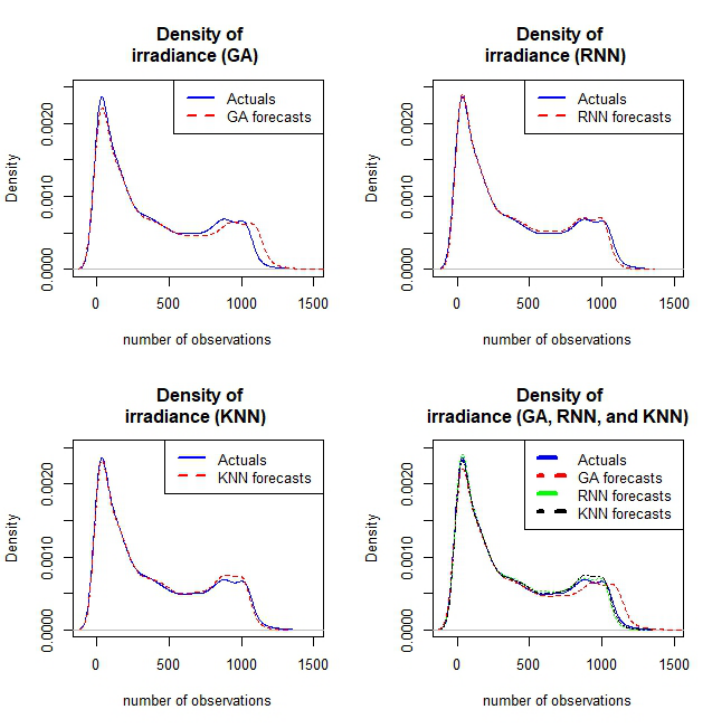
Figure 5. Density plots of the actual GHI (solid lines) and model’s forecasts (dashed lines) where Top left panel : Actual GHI and forecasts of GA Top right panel : Actual GHI and forecasts of RNN Bottom left panel : Actual GHI and forecasts of KNN and Bottom right panel : Actual GHI and forecasts of RNN, GA, and KNN where the actual GHI and forecasts of GA are shown by solid